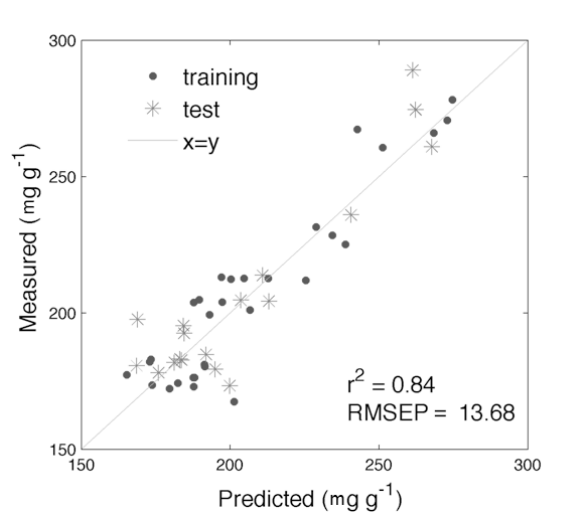
Figure 2. Scatter plots describing the measured and predicted total tea polyphenols for training and test using canopy spectra (mean centred). r 2 is coefficient of determination between model predictions and measured chemical concentrations on test data set, and RMSEP is the root mean square error of test data